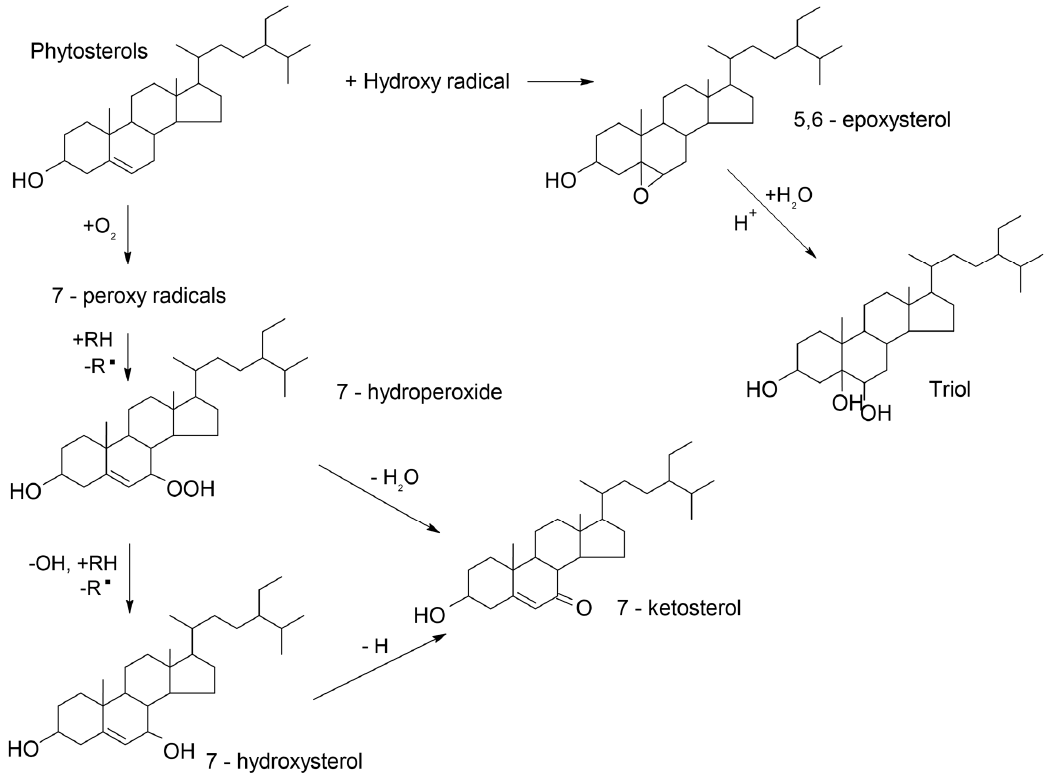
Figure 1. Scheme of phytosterol oxidation. Adapted from References [18,19]. The use of oil (natural source of phytosterols) in the frying process leads to their degradation. The amount of POP formed during frying mostly depends on the type of oil (amount of phytosterols, antioxidant content, and degree of unsaturation), the process conditions (temperature and time), and on the fried food (food composition). The way to reduce the oxidation during frying may be the use of oils with higher oxidative stability (low content of polyunsaturated fatty acids and high concentration of natural antioxidants) and addition of antioxidants. Oils with a low content of polyunsatu ‐ rated fatty acids are, for example, olive oils, and also modified oils, such as high oleic sunflower oil, high oleic rapeseed oil, or high oleic soybean oil. In this oil, the fatty acid profile was changed by increasing the presence of oleic acid (18:1) and minimizing the presence of linoleic and linolenic fatty acids (18:2 and 18:3). Another way to modify the oil is hydrogenation process. The hydrogenation process is commonly used today because it is easy and cheap; however, it leads to the formation of undesirable nutritionally trans fatty acids